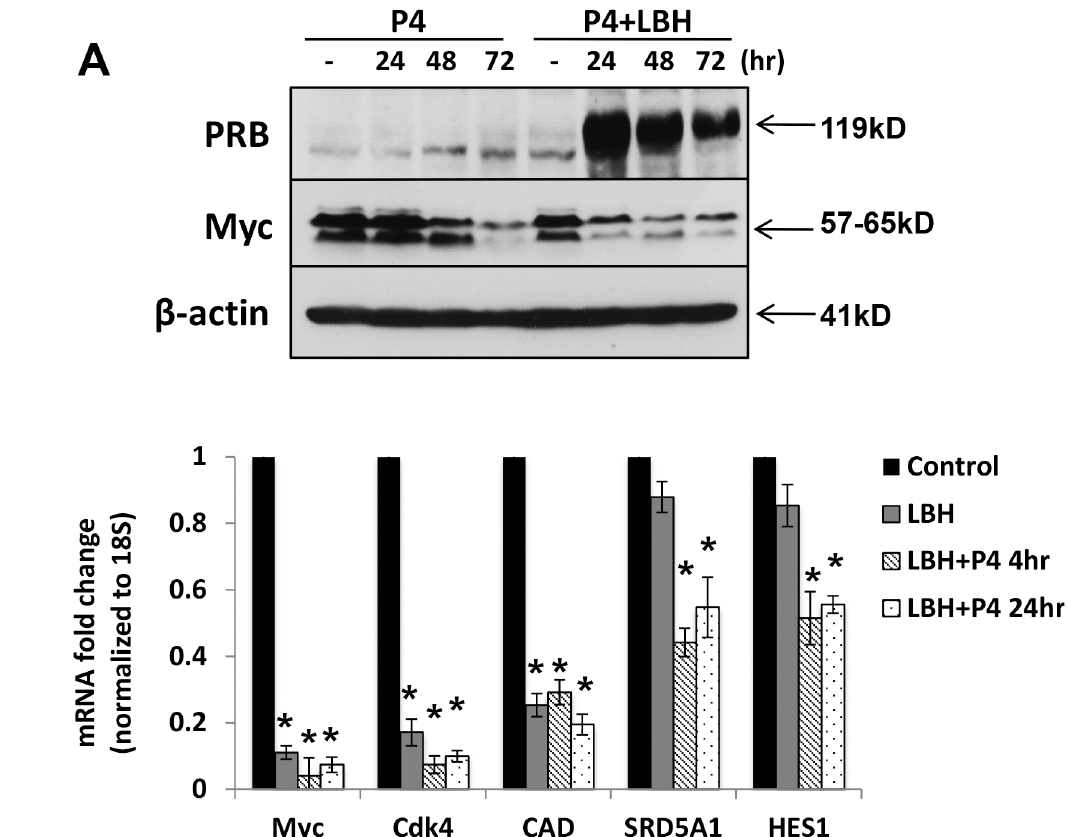
Fig 4. The combination of HDACi and progesterone negatively regulates Myc expression and activity in endometrial cancer cells. (A) Ishikawa cells were treated with 20 nM LBH589, 100 nM progesterone (P4) or the combination for the indicated times. PR and Myc protein expression was measured by Western blotting. β -actin serves as a loading control. (B) Expression of Myc and its downstream genes (CDK4, CAD, SRD5A1 and HES1) were analyzed by qRT-PCR in Ishikawa cells were treated with 20 nM LBH589 -/+100 nM P4 for 4 or 24 hrs. Data were normalized to 18S and calculated as the fold change relative to control. * p < 0.05 vs.